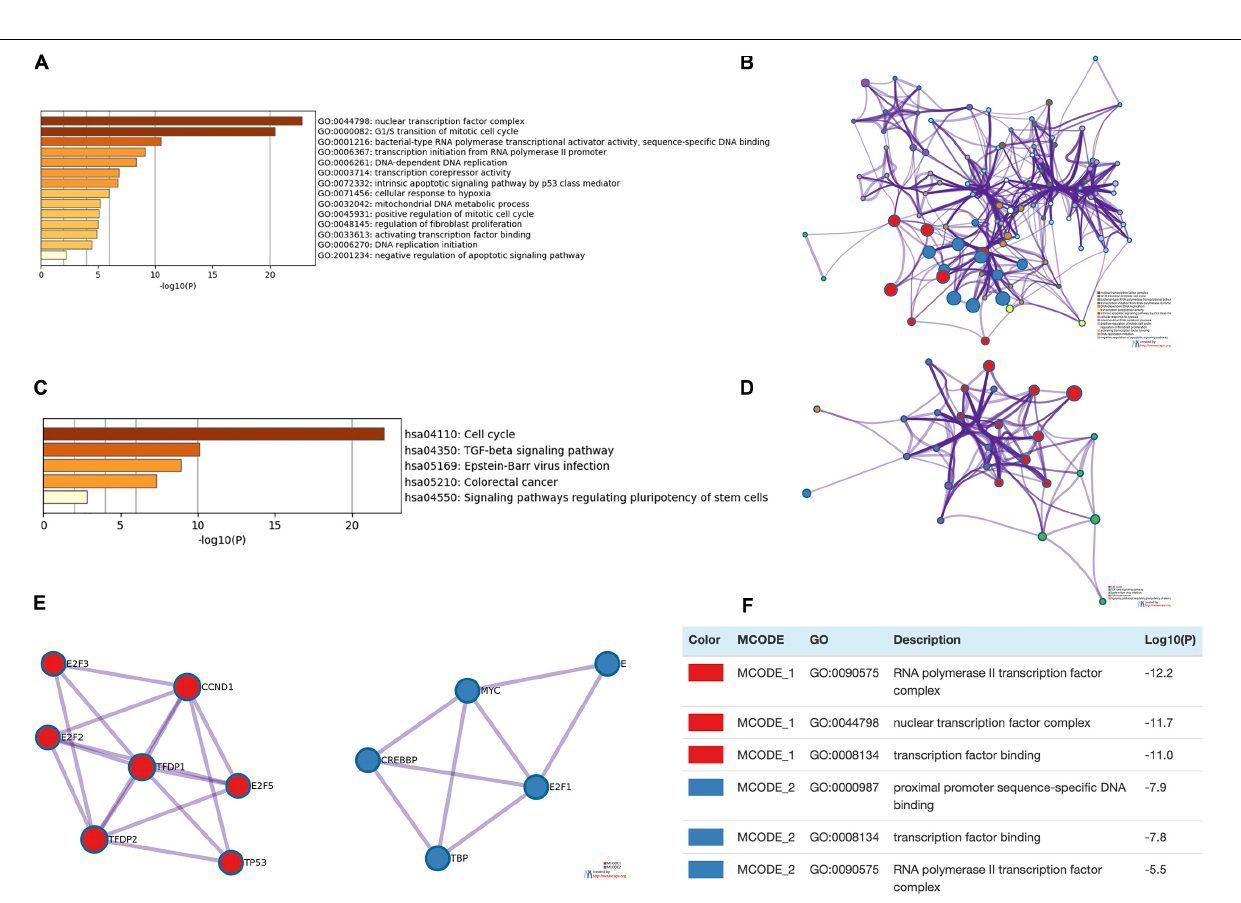
FIGURE 12 | Enrichment analysis of E2Fs and associated genes in UCEC. (A,B) Bar graph and network of top 20 enriched items in GO analysis. (C,D) Bar graph and network of the significantly enriched items based on KEGG pathways analysis. (E,F) Protein-protein interaction network and MCODE components in E2Fs and neighboring